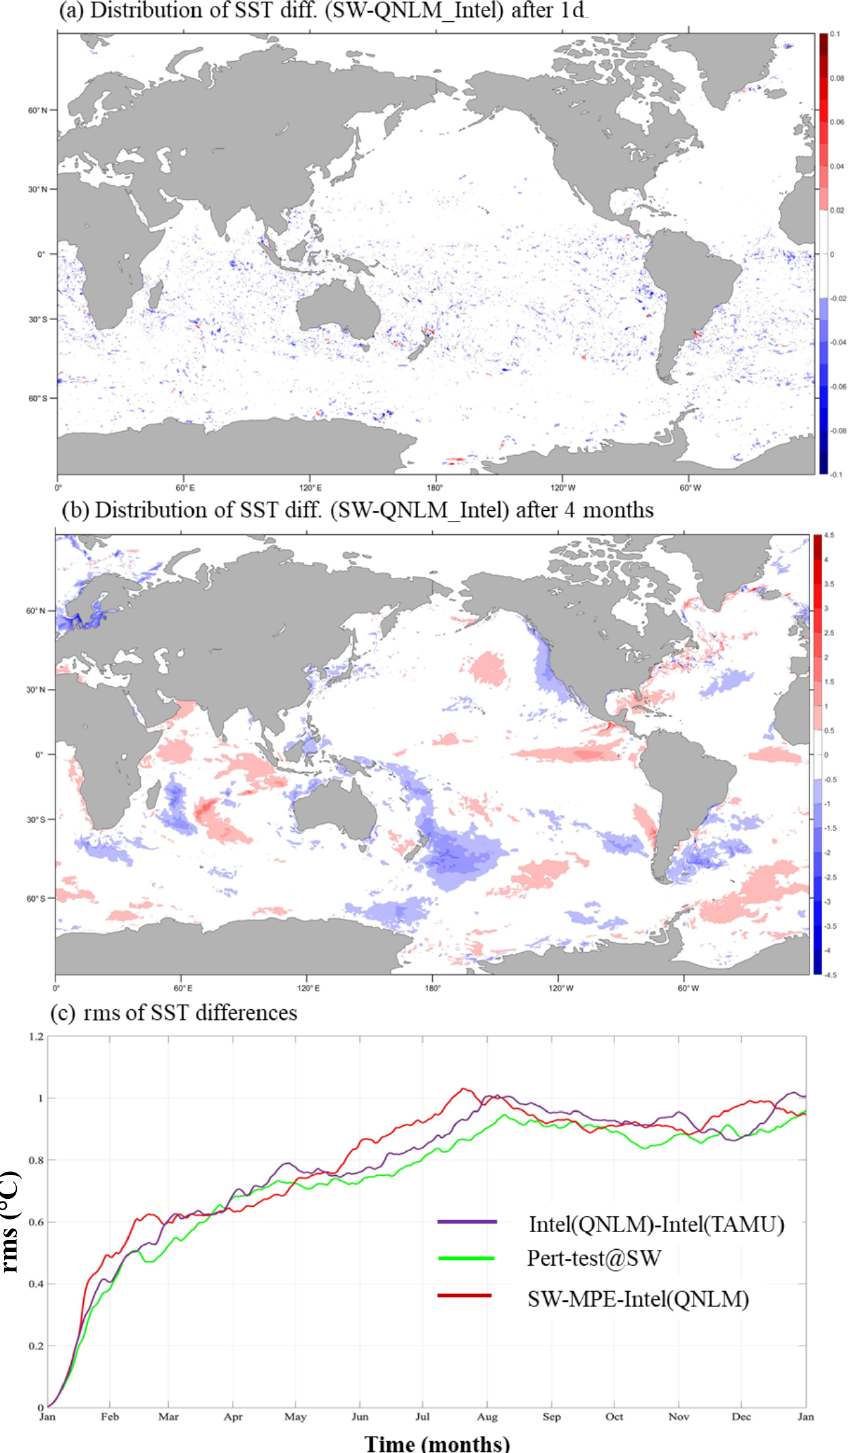
Figure 6. The distribution of differences in sea surface temperatures produced by the Sunway machine and Intel machine at TAMU after (a) 1d, (b) 1-year integration, and (c) the time series of root mean square (rms) of the differences between different machines and the perturbation